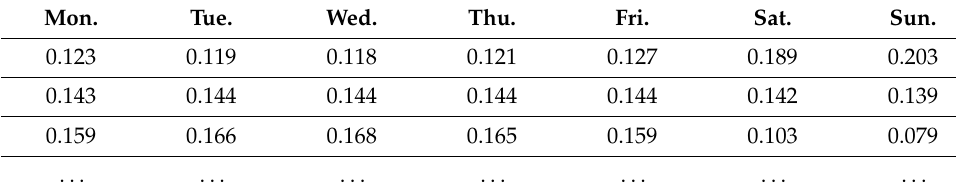
Table 1. Examples of P_week instances.